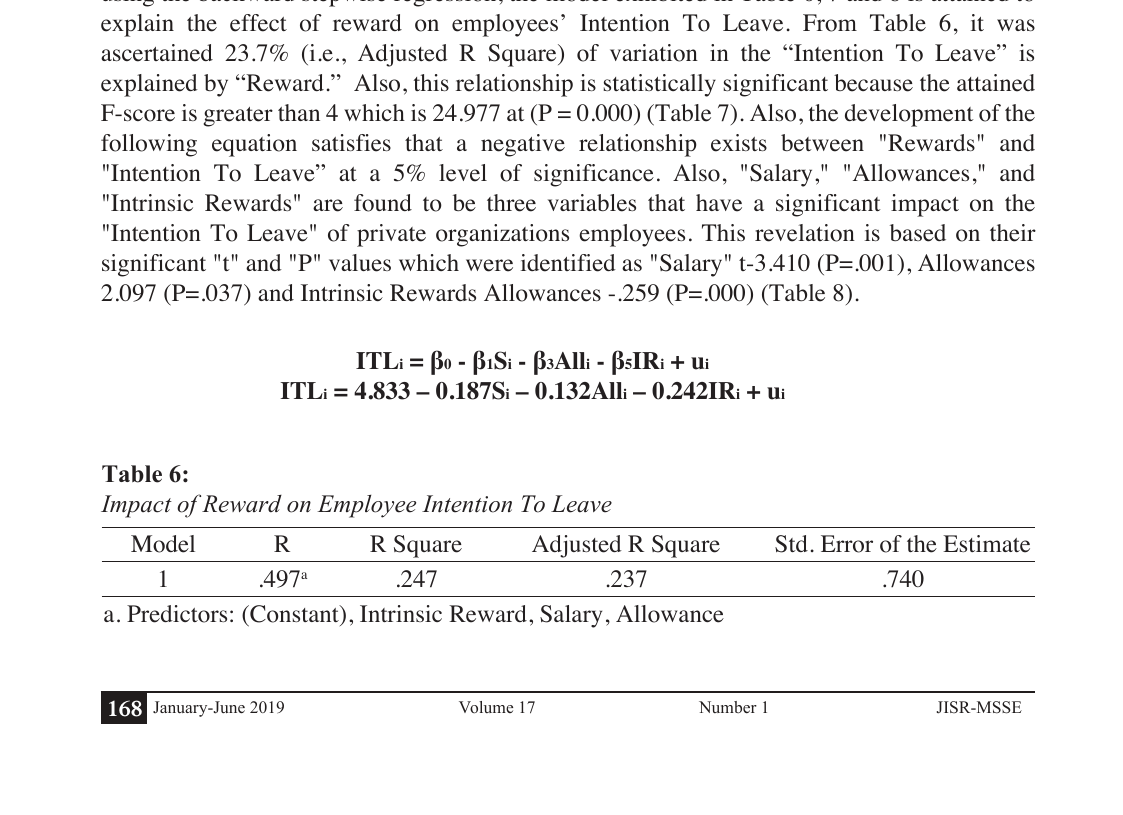
Table 5: Coefficients of Reward and Job Satisfaction Model Unstandardized Standardized t Sig. Coefficients Coefficients B Std. Error Beta 1.996 Salary Intrinsic Reward .246 Dependent Variable: Job